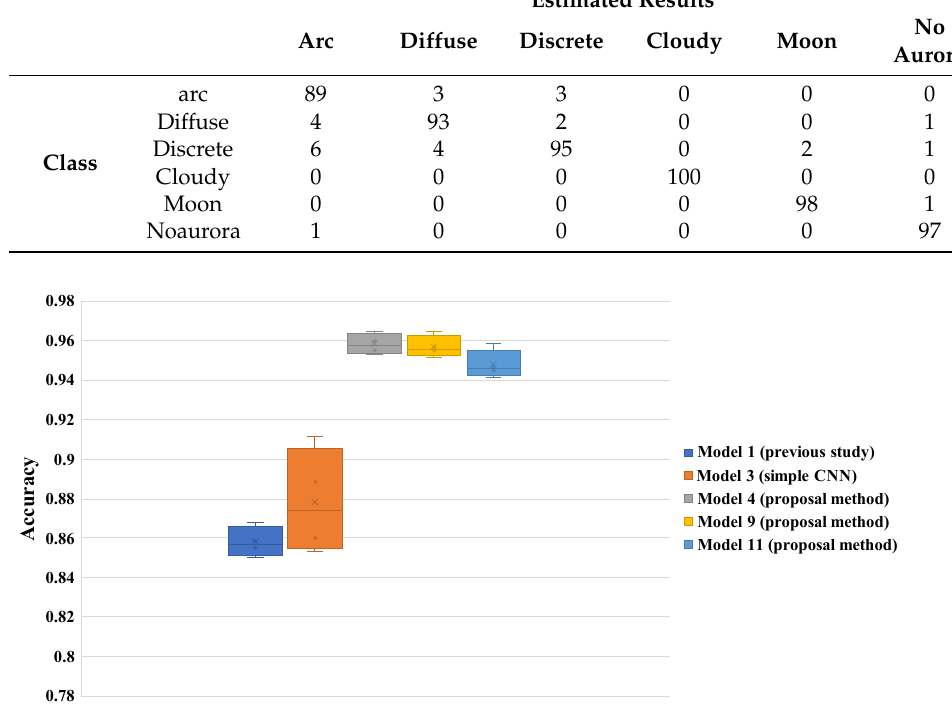
Figure 3. Results of aurora image